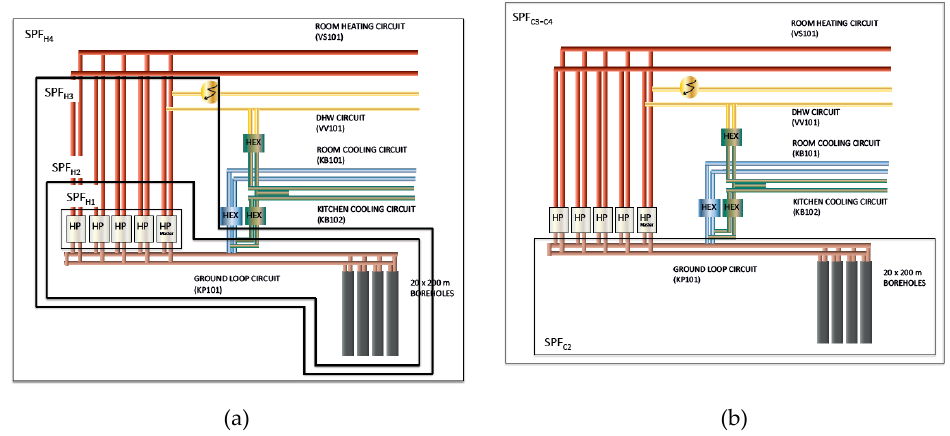
Figure 6. SEPEMO system boundaries [22] for heating SPF ( a ) and cooling SPF ( b ) for Studenthuset. SPF C1 cannot be calculated, as the system has no cooling unit.